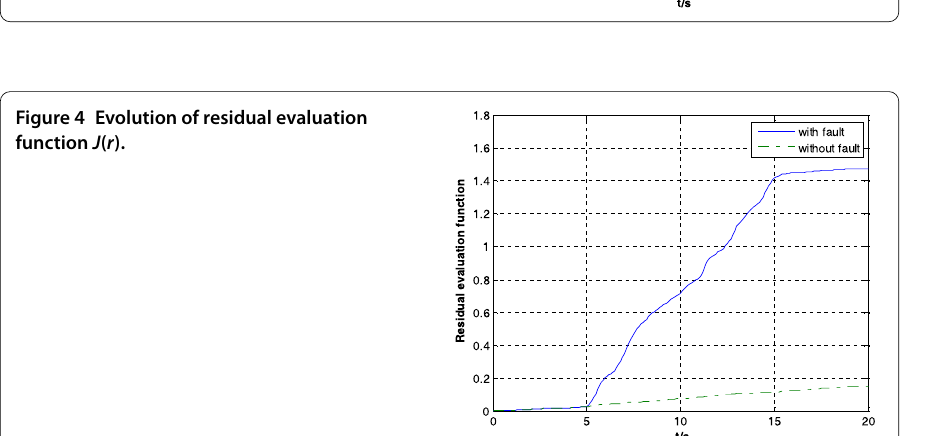
Figure 4 Evolution of residual evaluation function J ( r